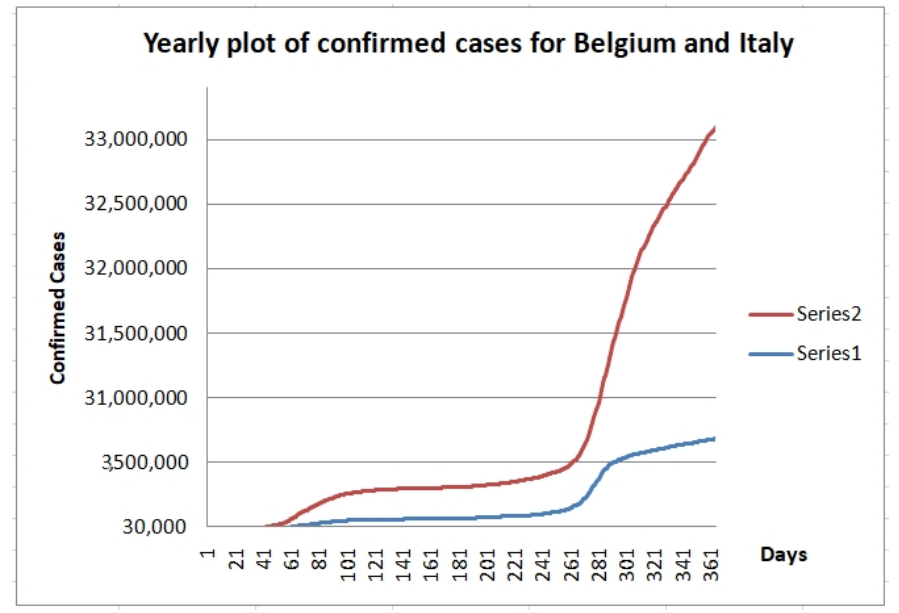
Figure 13. Time series of Belgium and Italy of the 22 January 2020 to 20 January 2021.